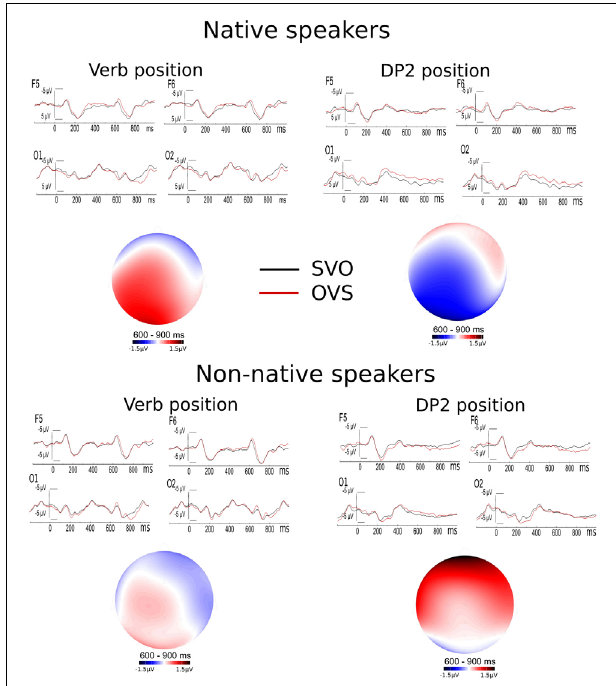
FIGURE 1 | The comparison between SVO and OVS conditions at verb and DP2 positions. Basque native speakers elicit a P600 effect at verb and a long lasting negative effect at second DP position. Non-native speakers only showed a P600 effect at second DP